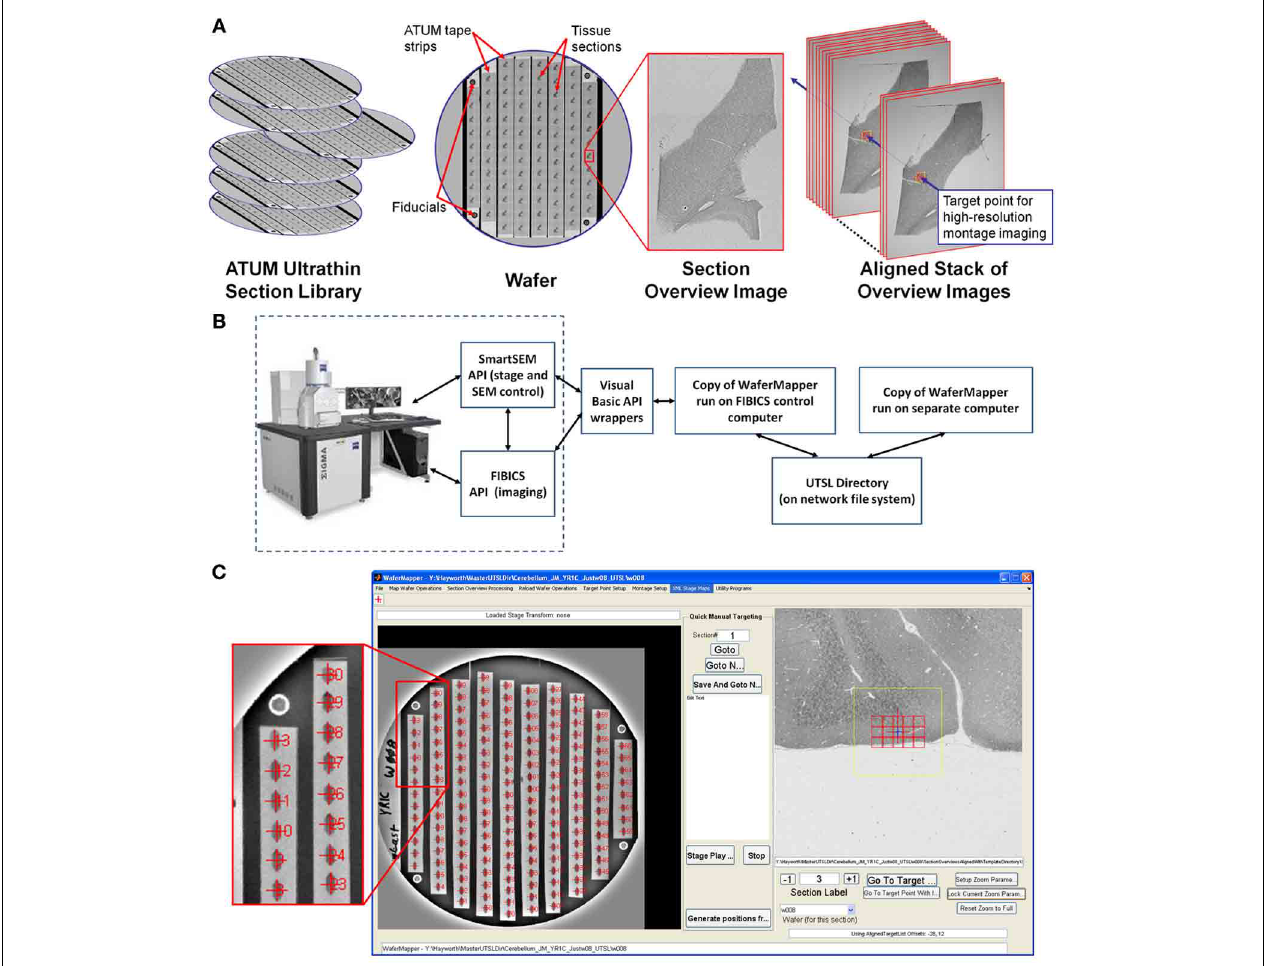
FIGURE 2 | Overview of WaferMapper terminology, SEM system integration, and Graphical User Interface (GUI). (A) Graphical depiction of some of the key terms described in the text. (B) Block diagram showing how one copy of the WaferMapper program is used to automate SEM imaging while a separate copy is used to handle offline tasks such a browsing the aligned section overviews stack and graphically planning montage imaging volumes. A central UTSL Directory structure organizes all metadata and images related to the library. (C) The WaferMapper GUI is organized around a wafer-level overview display (left) and a section overview display (right). Each